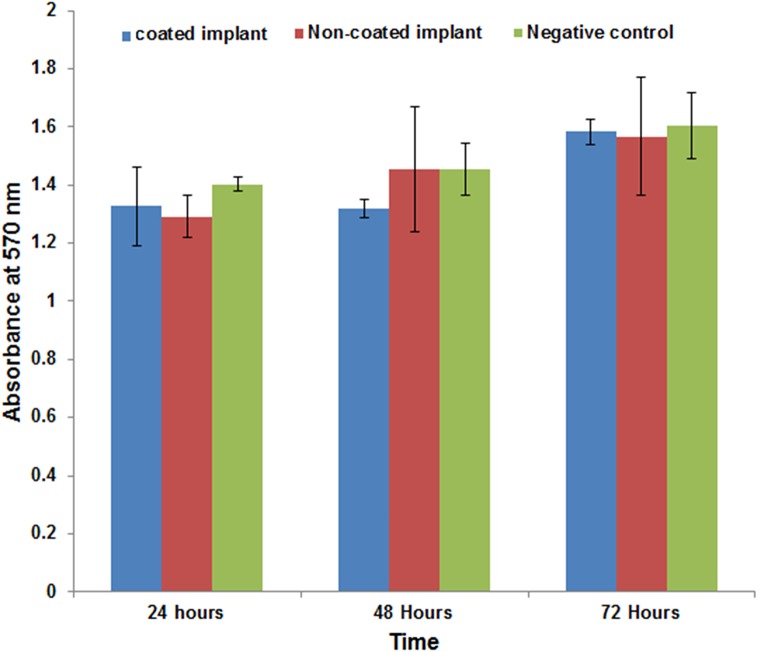
MTT assay results.